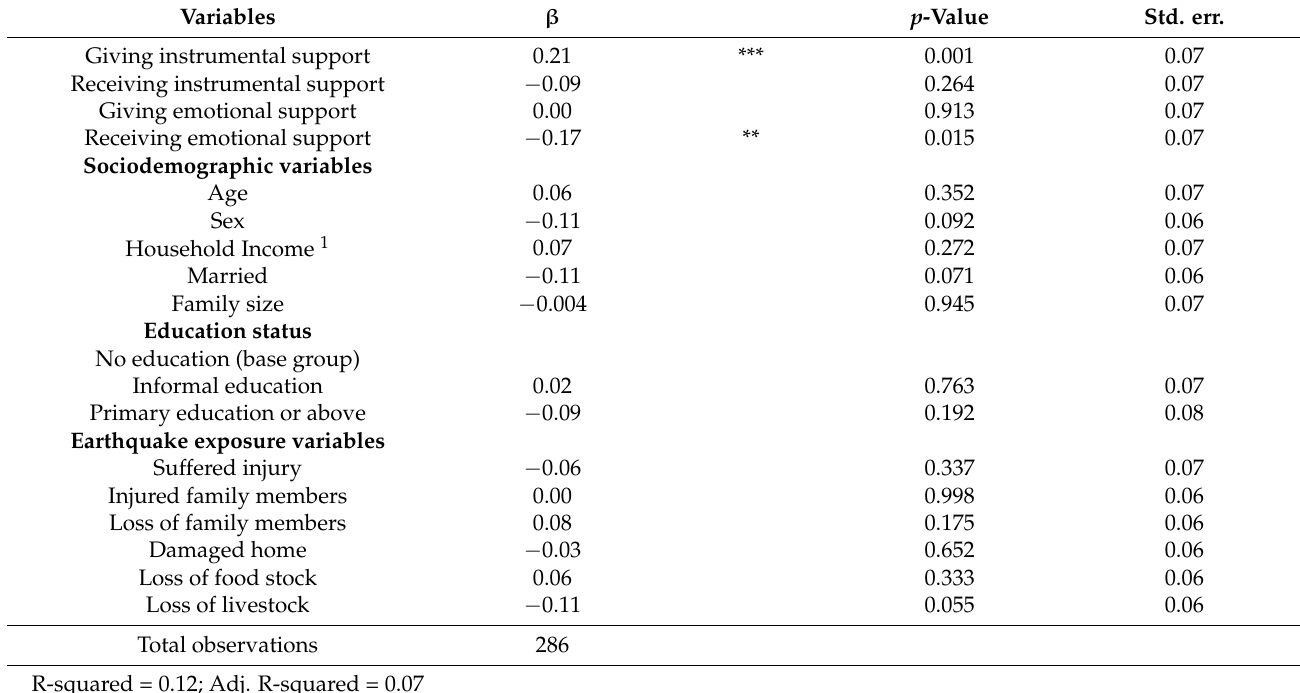
Table 4. Linear regression analysis predicting depression